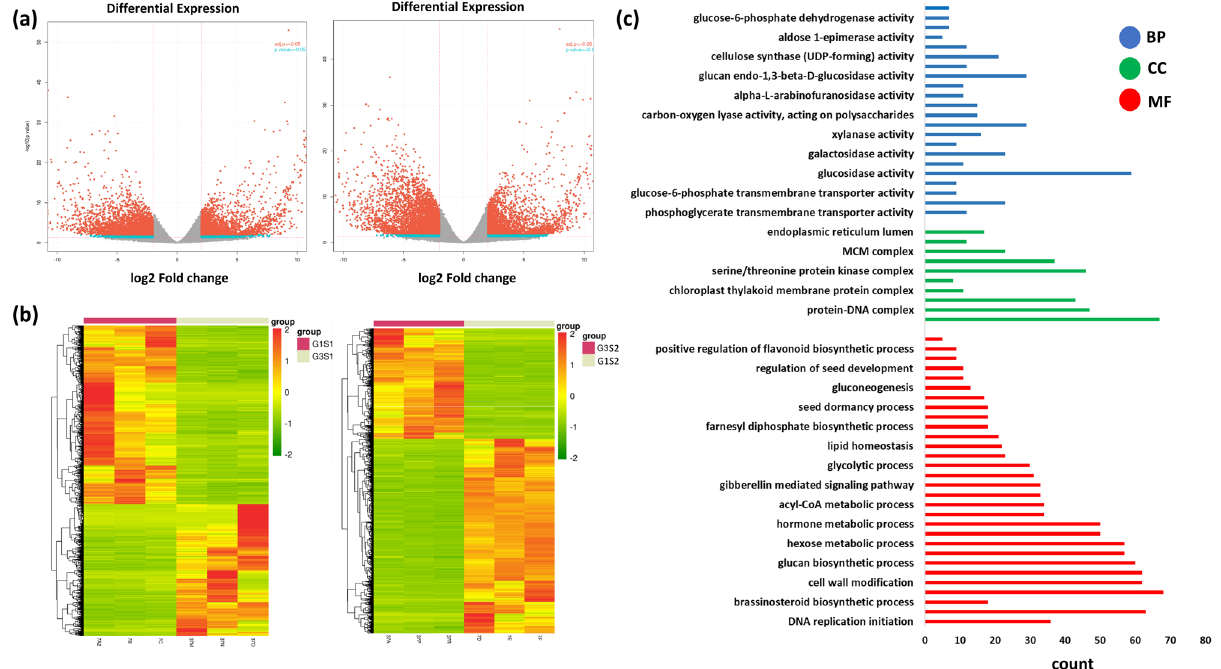
Figure 3. Representative expression profile and GO categorization of peanut seed transcriptome of the Spanish group varieties. (a) Volcano plot showing differential expression profile of genes. “Blue” indicates log2 fold change ≥ 2 and p value ≤ 0.05. “Red” indicates absolute log2 fold change ≥ 2 and adjusted p value ≤ 0.05. (b) Heatmap showing the DEGs in GG7 vs TG37A at S1 (left) and S2 (right). G1 = GG7 (red coloured cluster), G3 = TG37A (beige coloured cluster). Data is plotted with the heatmap.2 function of R package gplots (version 3.1.1). (c) These GO terms are classified into three categories (BP: Biological Processes, CC: Cellular Component, MF: Molecular